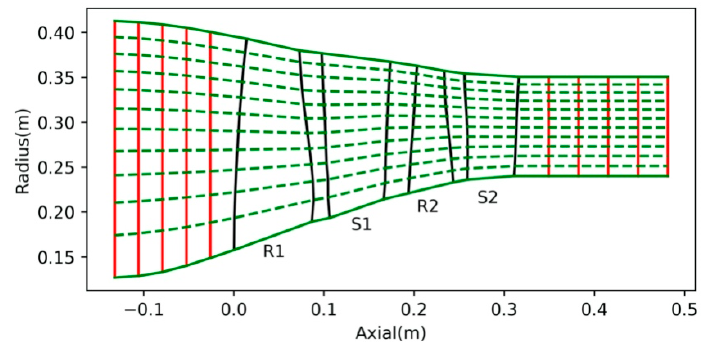
Figure 13. Computation grids for the two-stage transonic compressor.